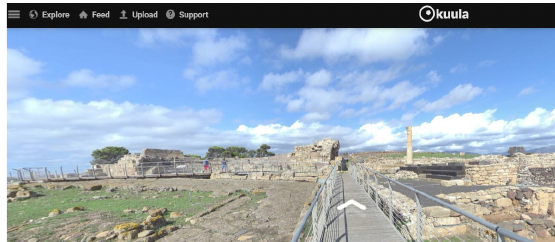
Figure 11. Point of view during the tour route where the white arrow that allows movements appears: clicking on it takes you to Figure 12.